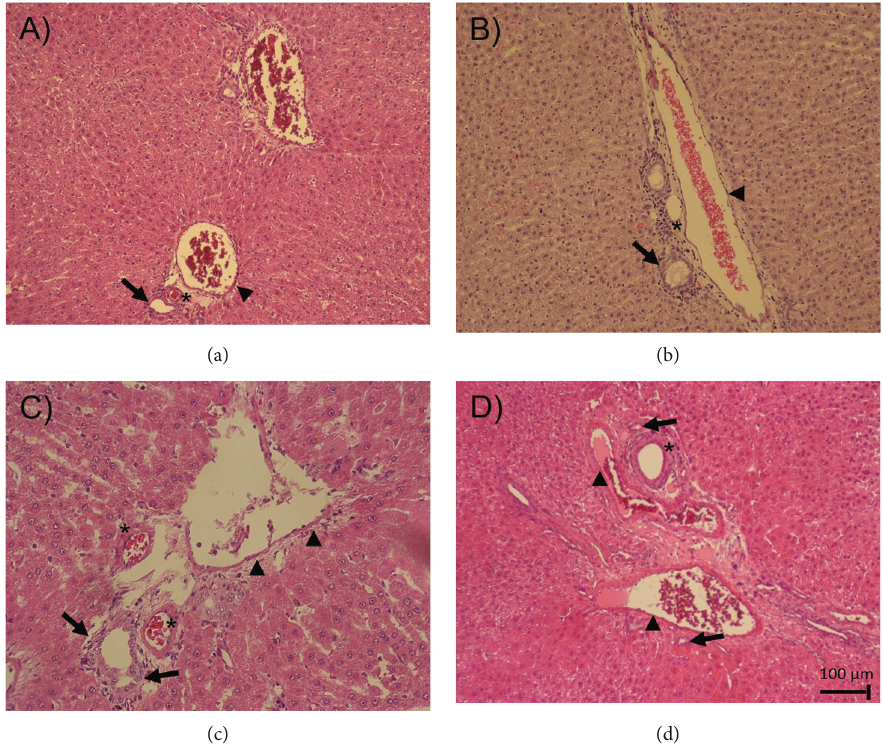
Figure 7: Liver slides HE stained from the IC, NIL, PCA, and PCA+NIL groups. (a) Slide from an IC animal. Normal pattern of the liver lobules, triads (hepatic artery ∗ ), bile ducts (arrow), portal vein (arrowhead), and blood sinusoids are apparent. Neither in fl ammatory in fi ltrates nor necrosis or fi brosis is present. (b) The NIL group. Similar normal structural patterns of the IC liver morphology are discernible. (c) PCA slide. Evident morphological changes are noted in the periportal zone, increased collagen deposits, thickening of the bile ducts (arrows), artery walls ( ∗ ), and portal veins (arrowhead). (d) PCA+NIL slide. A restored morphological pattern of hepatocytes and sinusoids ( ∗ ) is apparent, as well as slimming of the portal vein wall (arrowhead). All images taken at 20x magni fi cation. n = 5 − 6